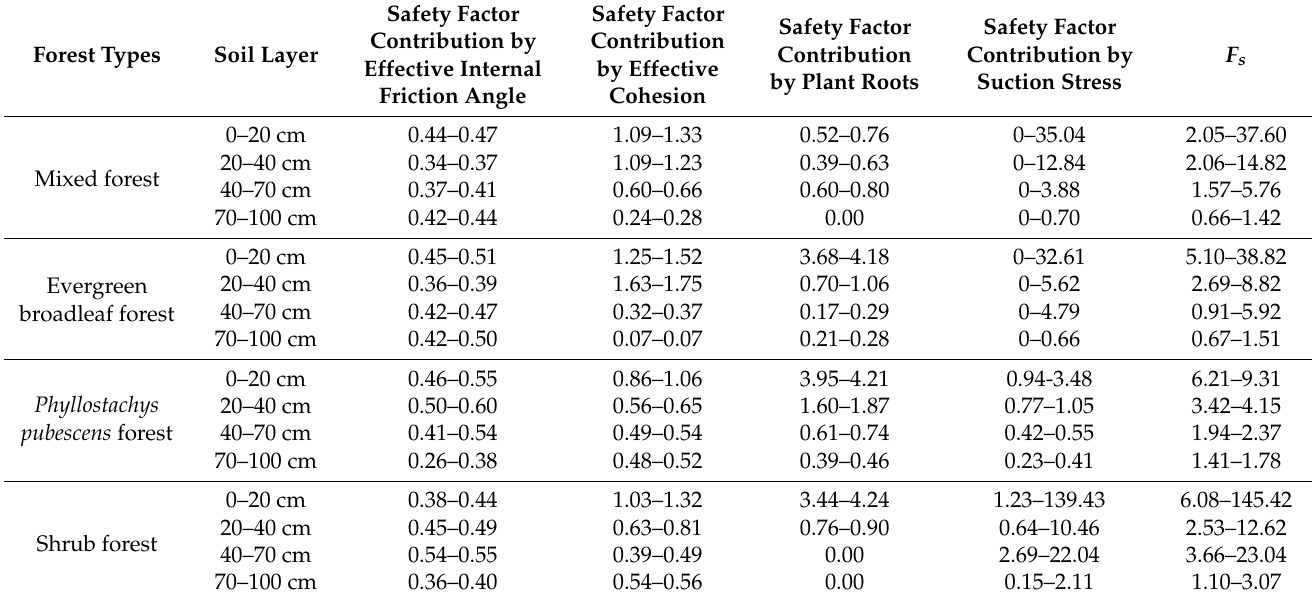
Table 3. Contribution of each influencing factor to hillslope safety